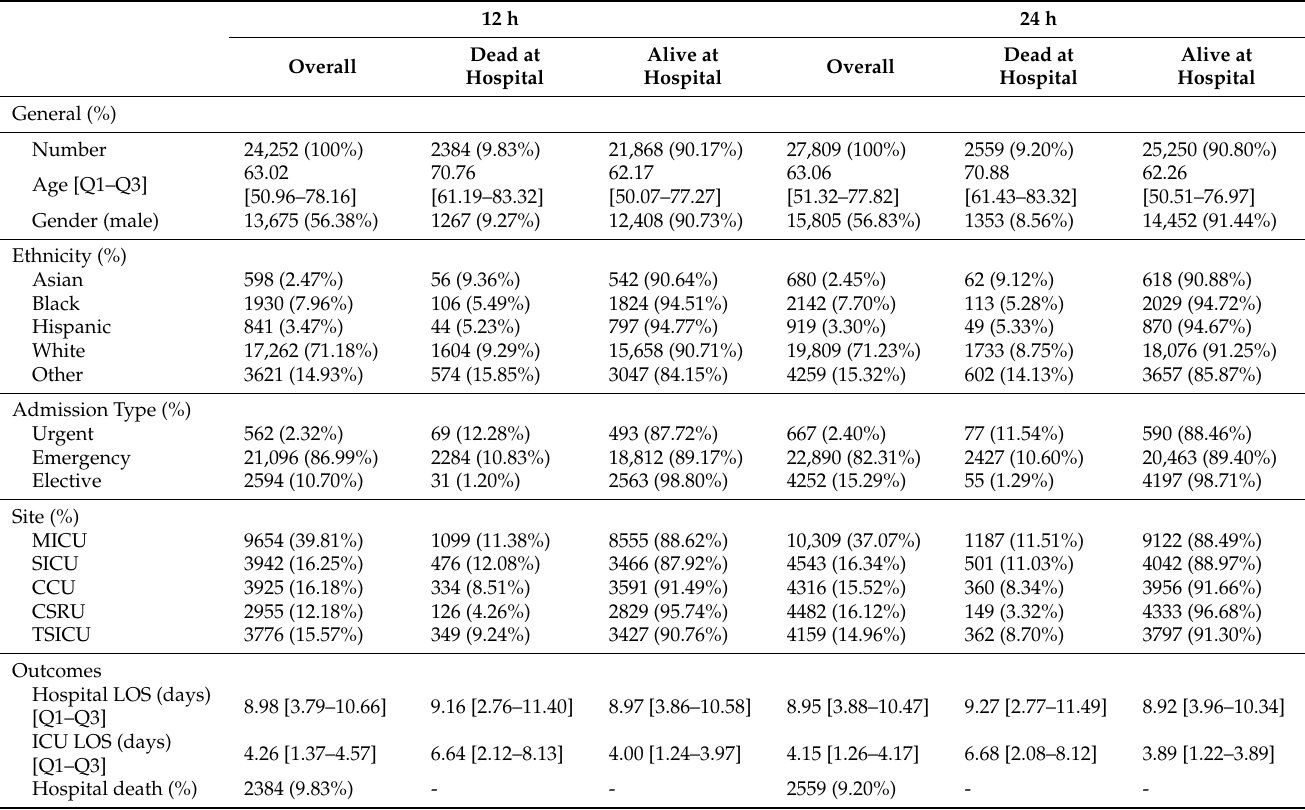
Table 2. Selected Patient Demographic